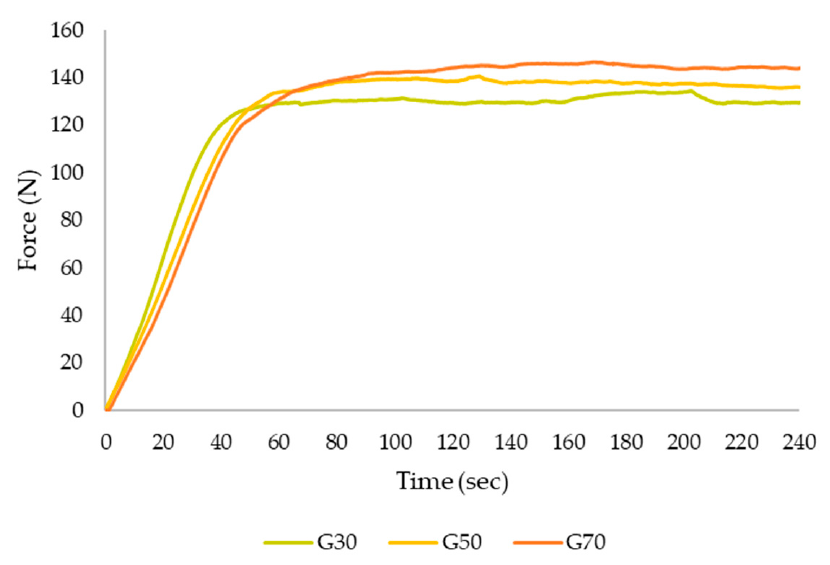
Figure 2. Example of force vs. time curves during forward extrusion measurement for apricot gel before 3D printing. (G30: Gel 30% pulp; G50: Gel 50% pulp; G70: Gel 70% pulp).